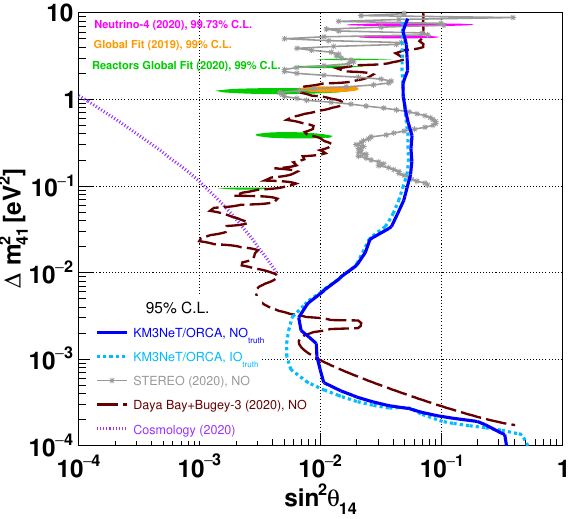
Figure 9 . The 95% C.L. KM3NeT/ORCA sensitivity to the mixing parameter θ 14 , for different values of ∆ m 2 , for three years of data taking. Sensitivity results are compared with current upper 41 limits from cosmology [13], STEREO [46], and Daya Bay+Bugey-3 [44]. Current anomaly regions are also reported, from Neutrino-4 [47], global fits [9] and reactors global fits [48]. The excluded region is the one on the right of the